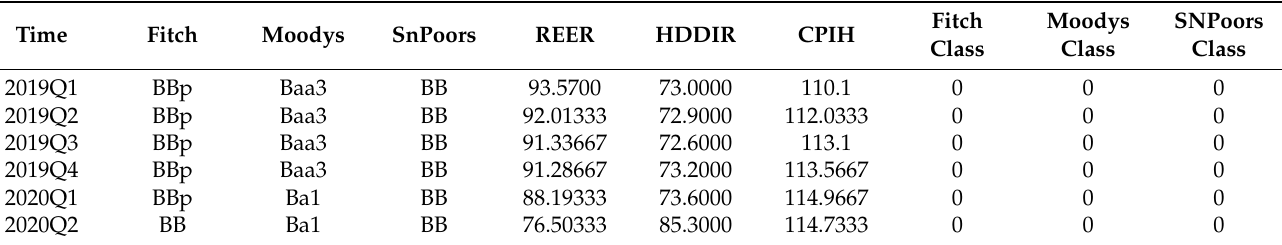
Table 8. Quarterly data from 2019 to